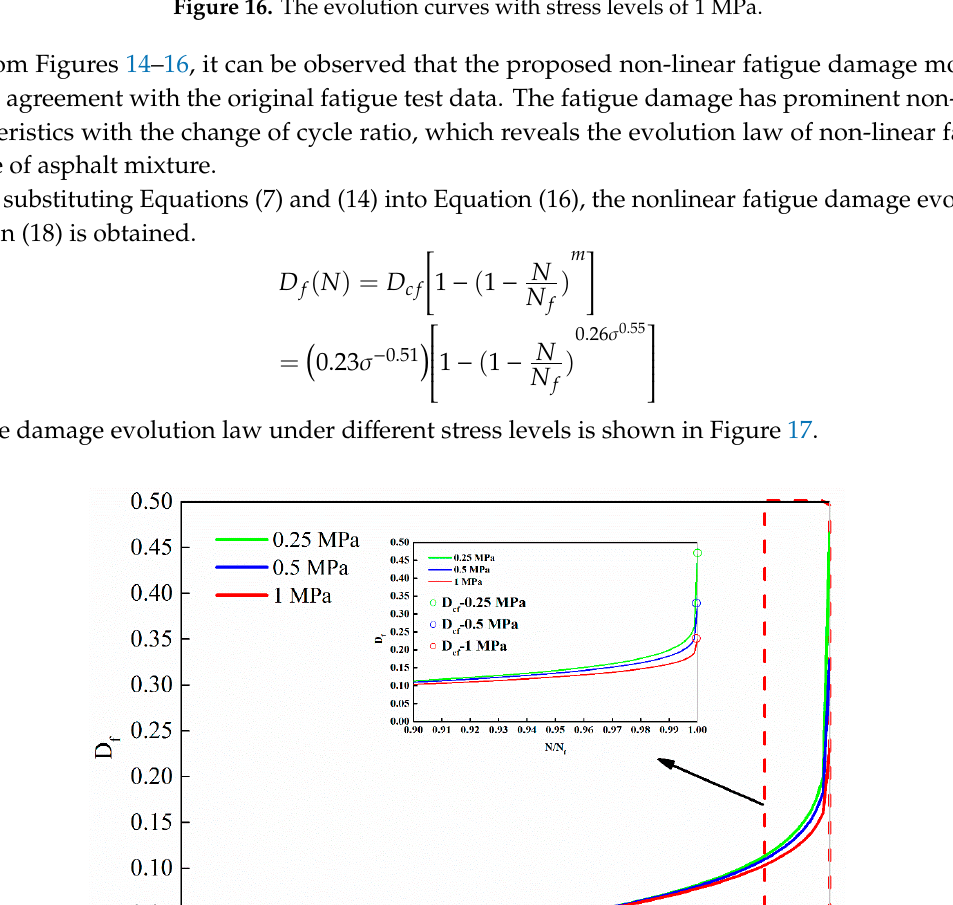
Figure 16. The evolution curves with stress levels of 1 MPa.